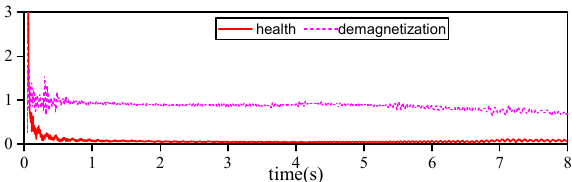
Figure 11. Comparison of 2/4th-order harmonic between partially demagnetized and healthy PMSMs under nonstationary conditions (experiment).